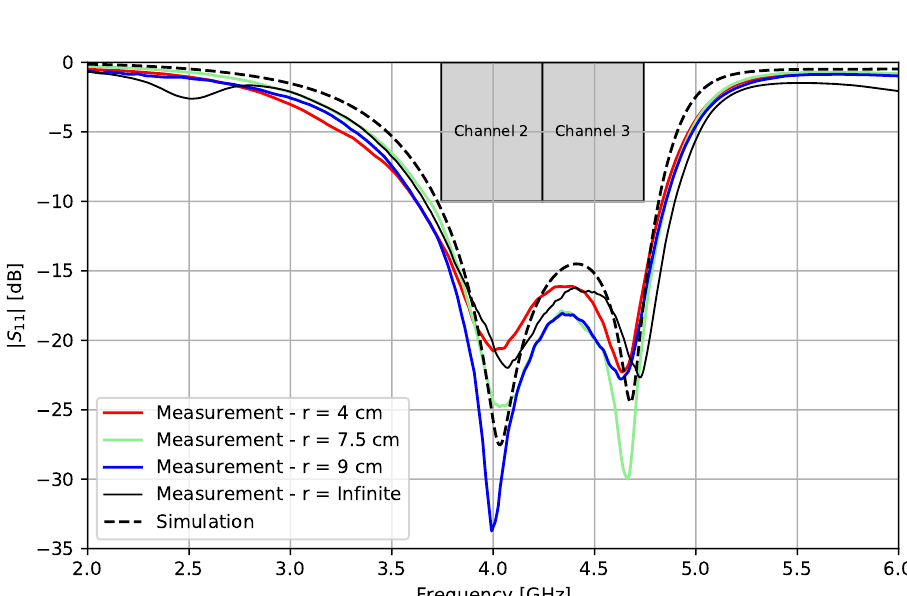
Figure 5. Magnitude of the simulated and measured reflection coefficient S 11 of the cavity-backed slot antenna as a function of the frequency while subject to mechanical bending along the x-axis in the H-plane and for different bending radii r , frequently encountered on the human